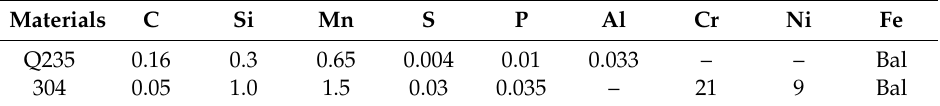
Table 1. The chemical composition of the low carbon steel and stainless steel